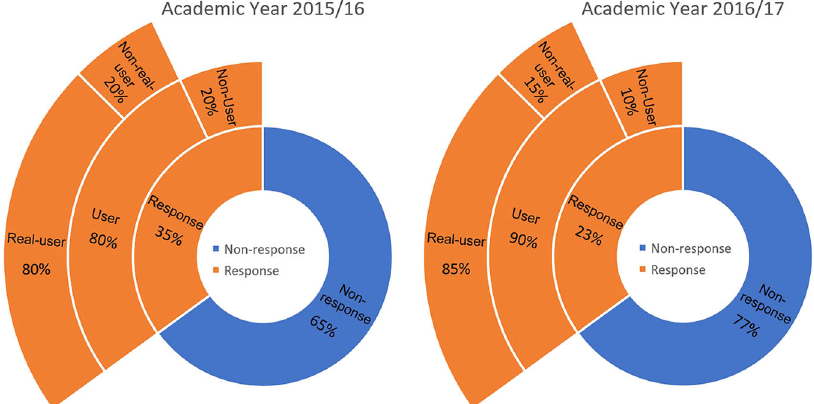
Fig. 5 Online questionnaire responses provided by learners (2015 – 2017). Results from an analysis of the response rates by learners to an online